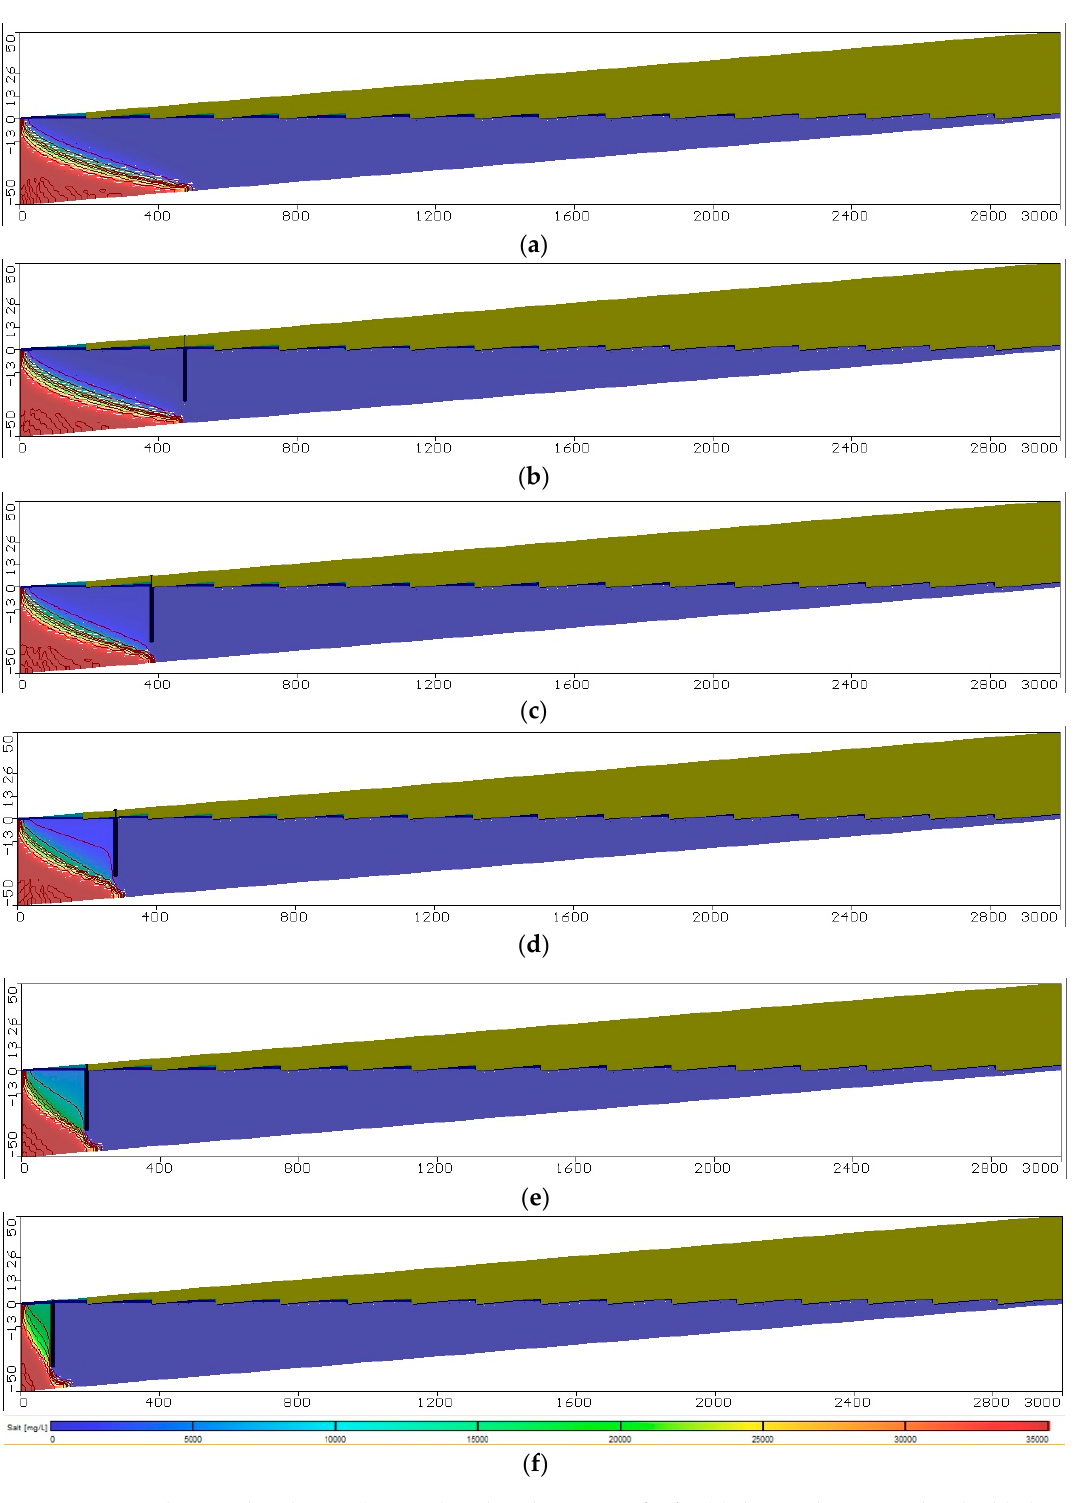
Figure 12. Saltwater distribution (in mg / L) in the Akrotiri aquifer for ( a ) the steady state and embedded barrier wall with d b / d = 0.7 and ( b ) X b / L o = 1.0, ( c ) X b / L o = 0.8, ( d ) X b / L o = 0.6, ( e ) X b / L o = 0.4 and ( f ) X b / L o = 0.2.